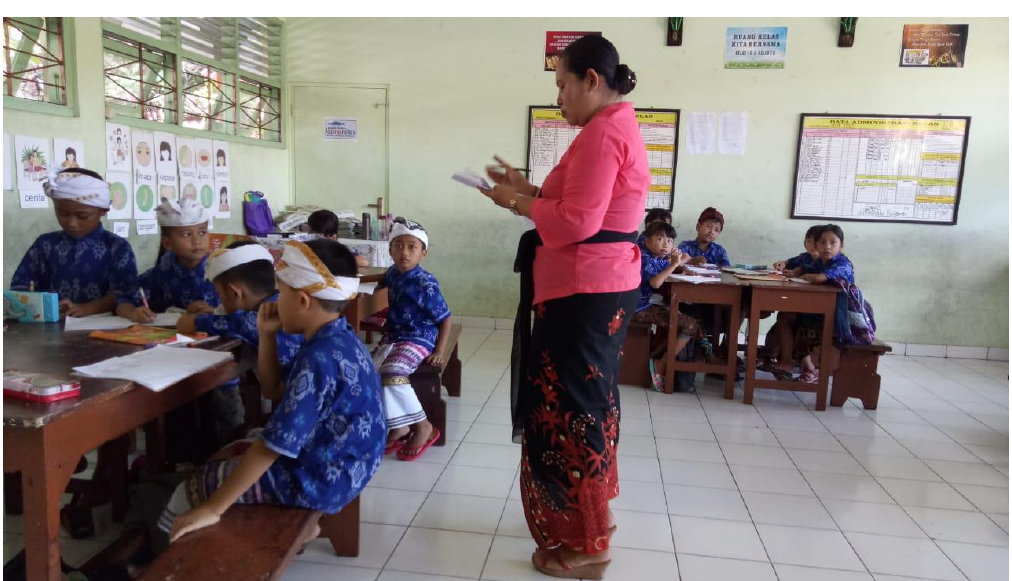
Figure 1. Learning at SDN 12 Sanur